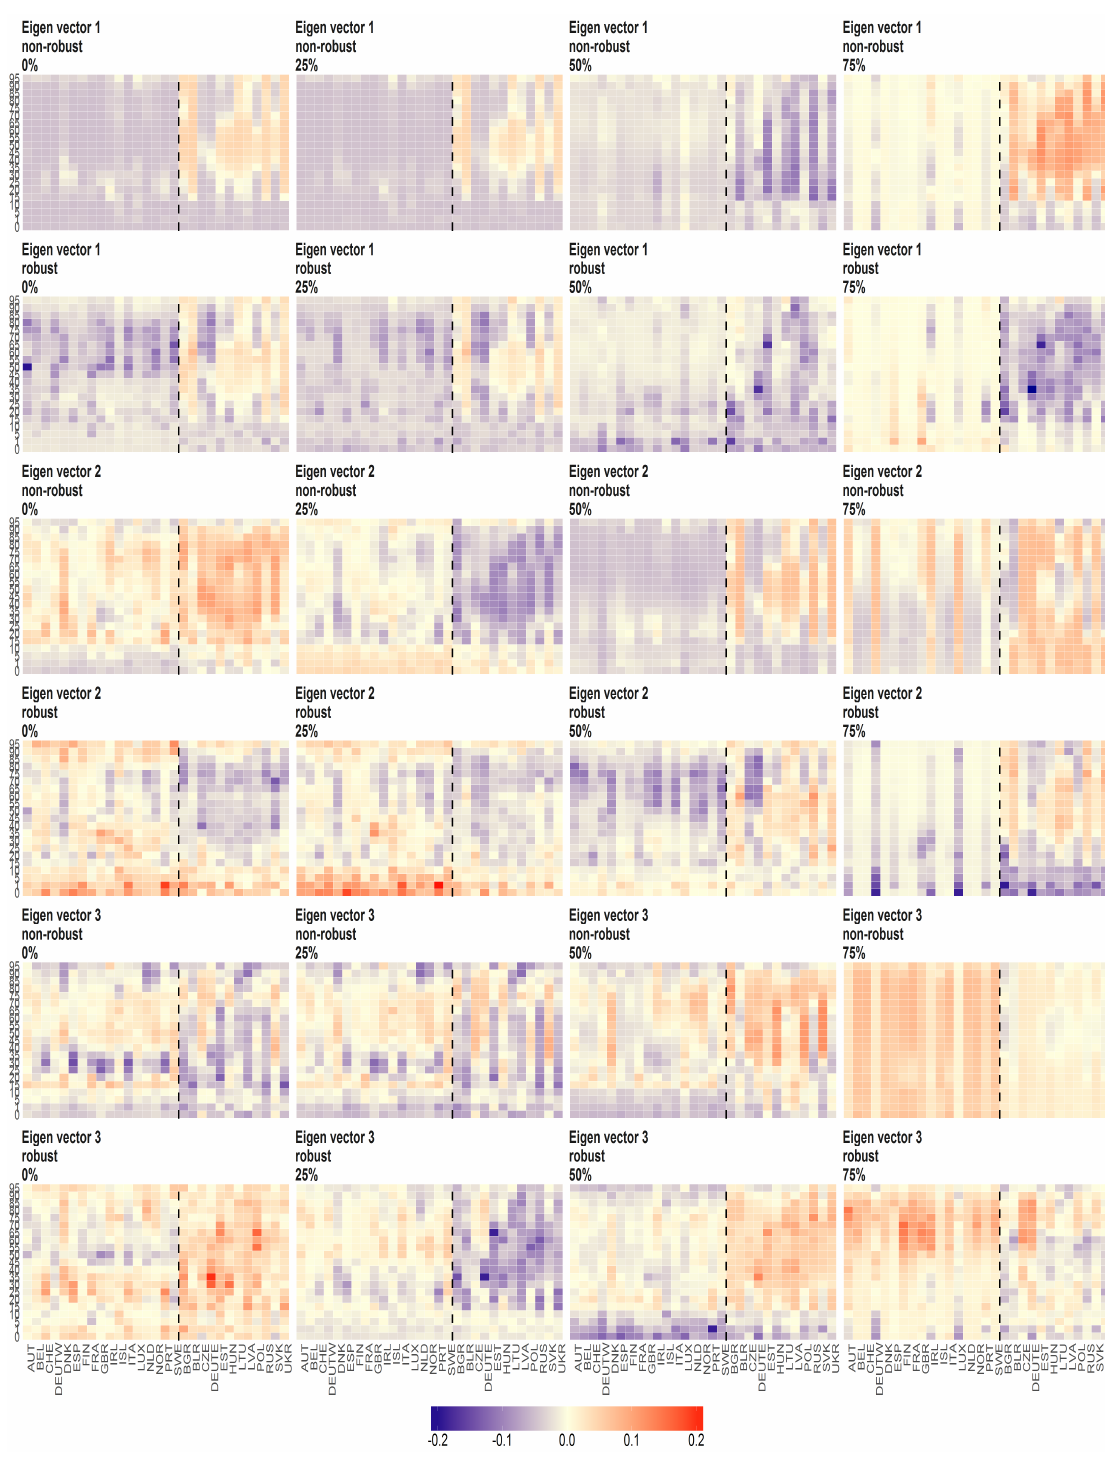
Figure 28. The eigenvectors (y axis) over the joint distribution of countries (x axis) obtained using PPCA for male population of Death Rates. Every row of subfigure corresponds to different eigenvector. Every column corresponds to different level of maximum missing values per observation (0%, 25%, 50% and 75%). The blue line corresponds to robust standardisation whereas red line to non-robust standardisation of